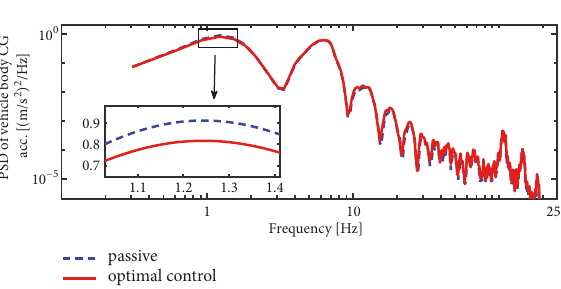
Figure 11: Frequency response of vehicle body